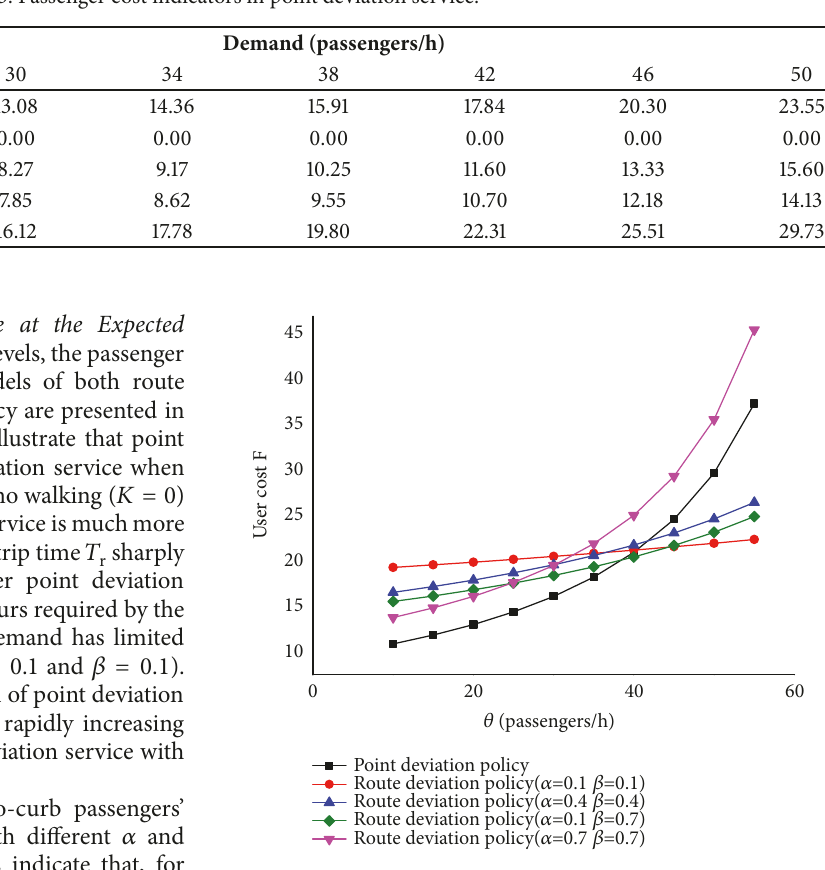
Figure 4: Comparison of system performance at the expected demand